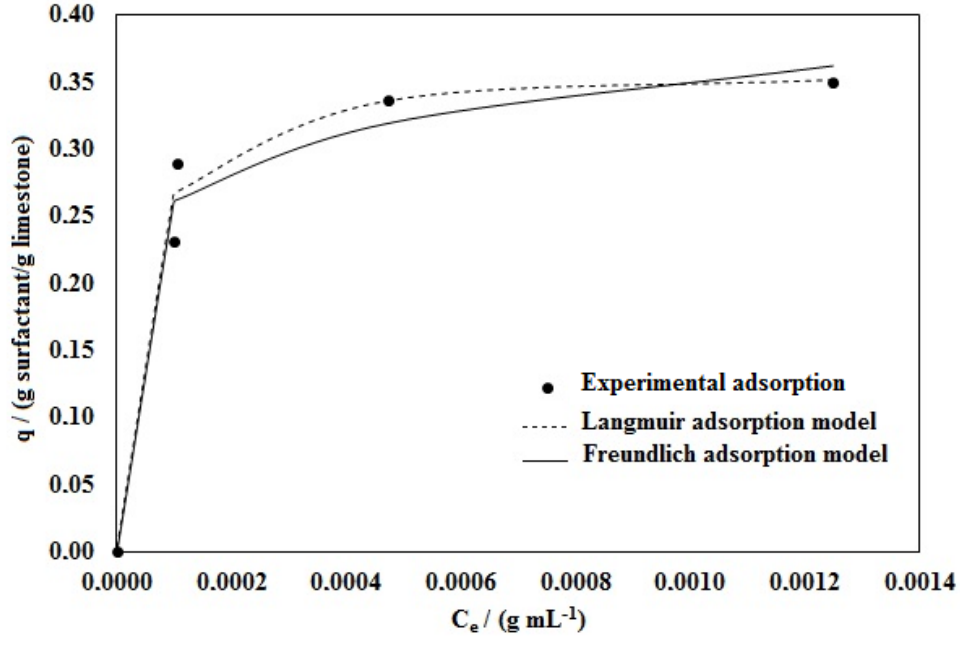
Figure 2. Langmuir and Freundlich adsorption isotherms for the SCO solution (3 g L −1 ) at 30